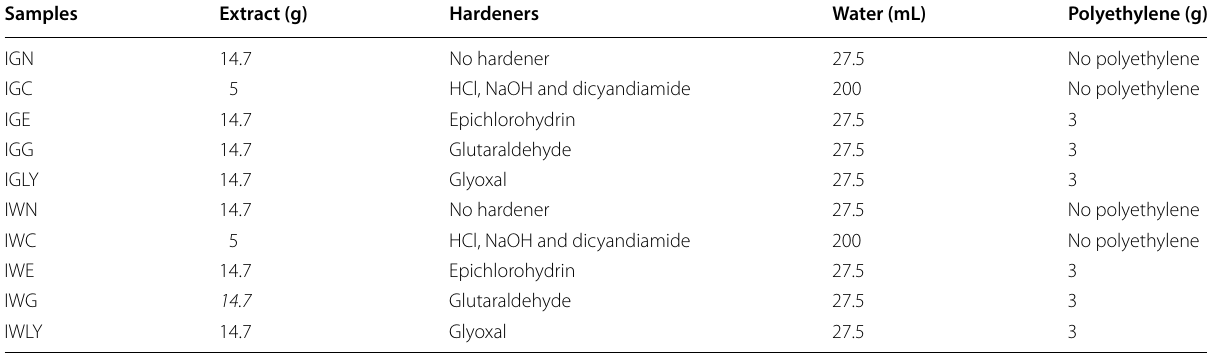
Table 2 Formulation parameters for unmodified and modified Irvingia-based adhesives